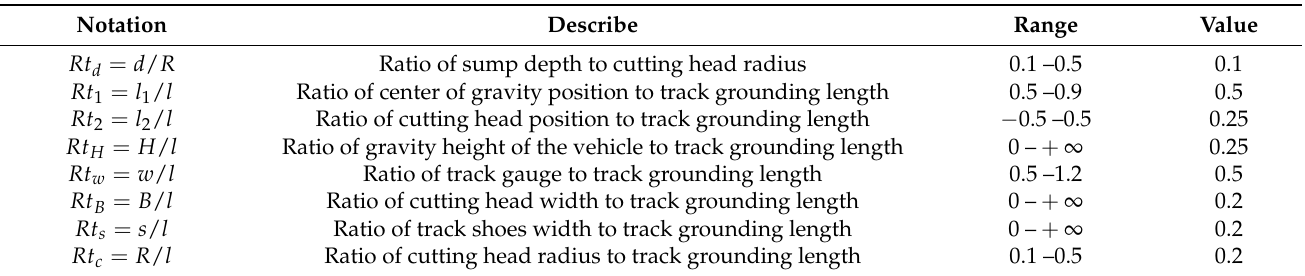
Table 4. Table 3. Ratios and their value ranges.